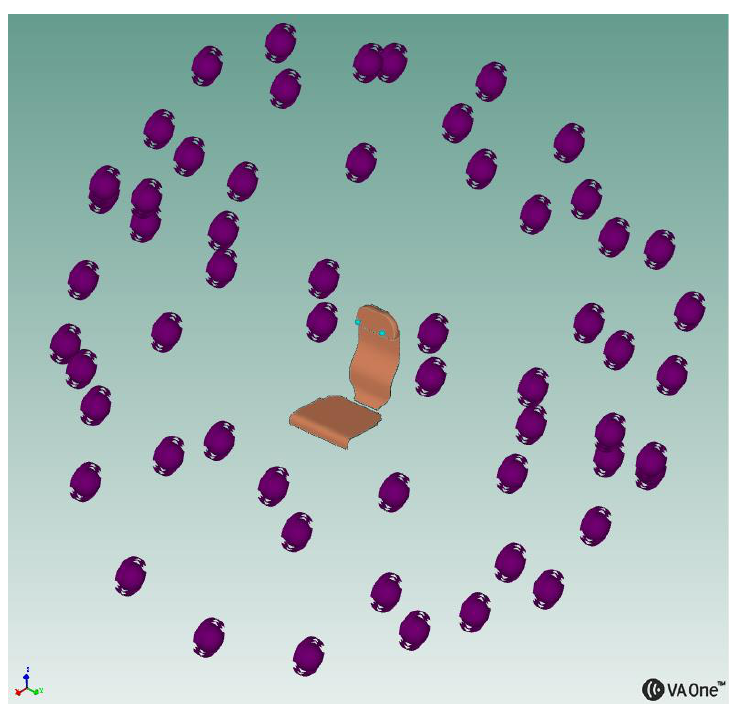
Figure 5. BEM loading conditions, with highlight of spatial monopole distribution.